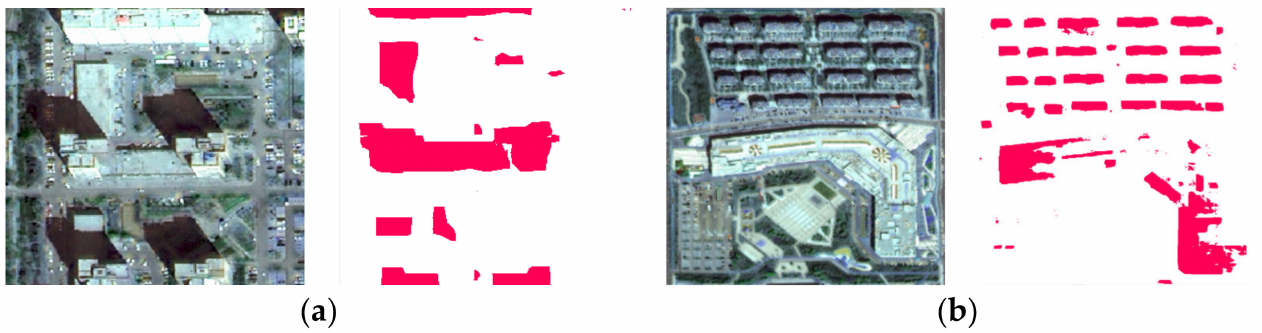
Figure 15. Some false results in building extraction. ( a ) Mistaken segmentation in the podium, ( b ) division of a large, rectangular